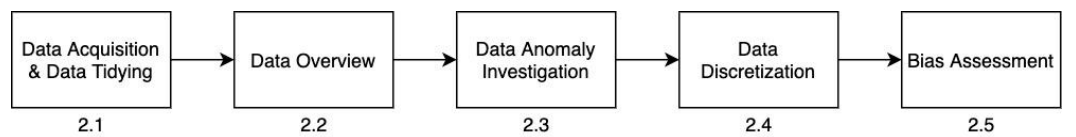
Figure 1. Conceptual Data Investigation Flow in the Subsections.